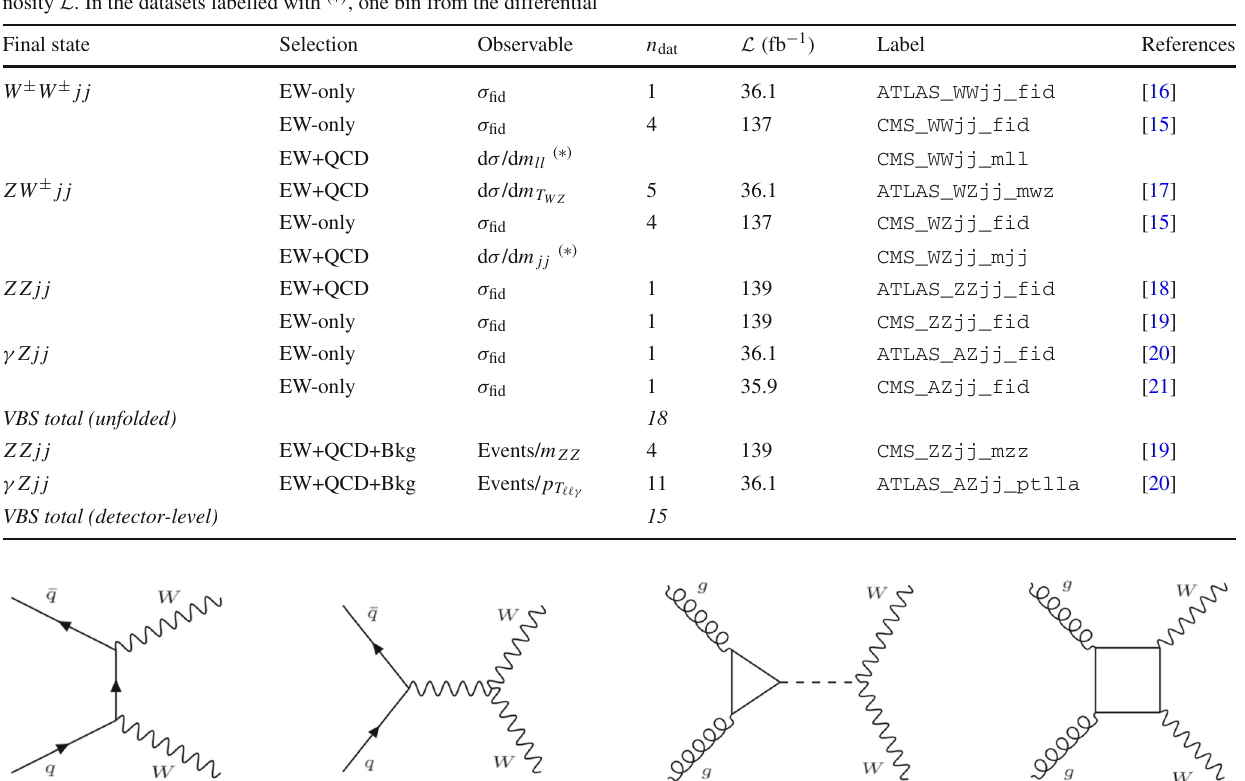
distribution has been traded for the fiducial cross section. We separate the unfolded (baseline) from the detector-level (used for cross-checks)